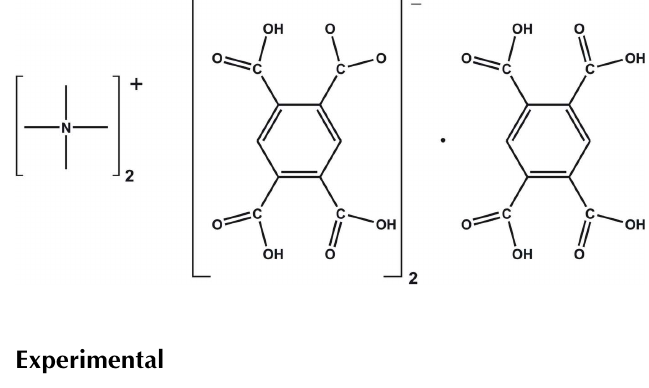
Data collection Bruker Kappa APEXII diffractometer Absorption correction: multi-scan ( SADABS ; Sheldrick, 1998)